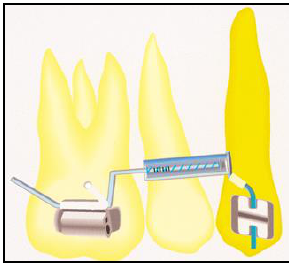
Figure 9: Hybrid retraction